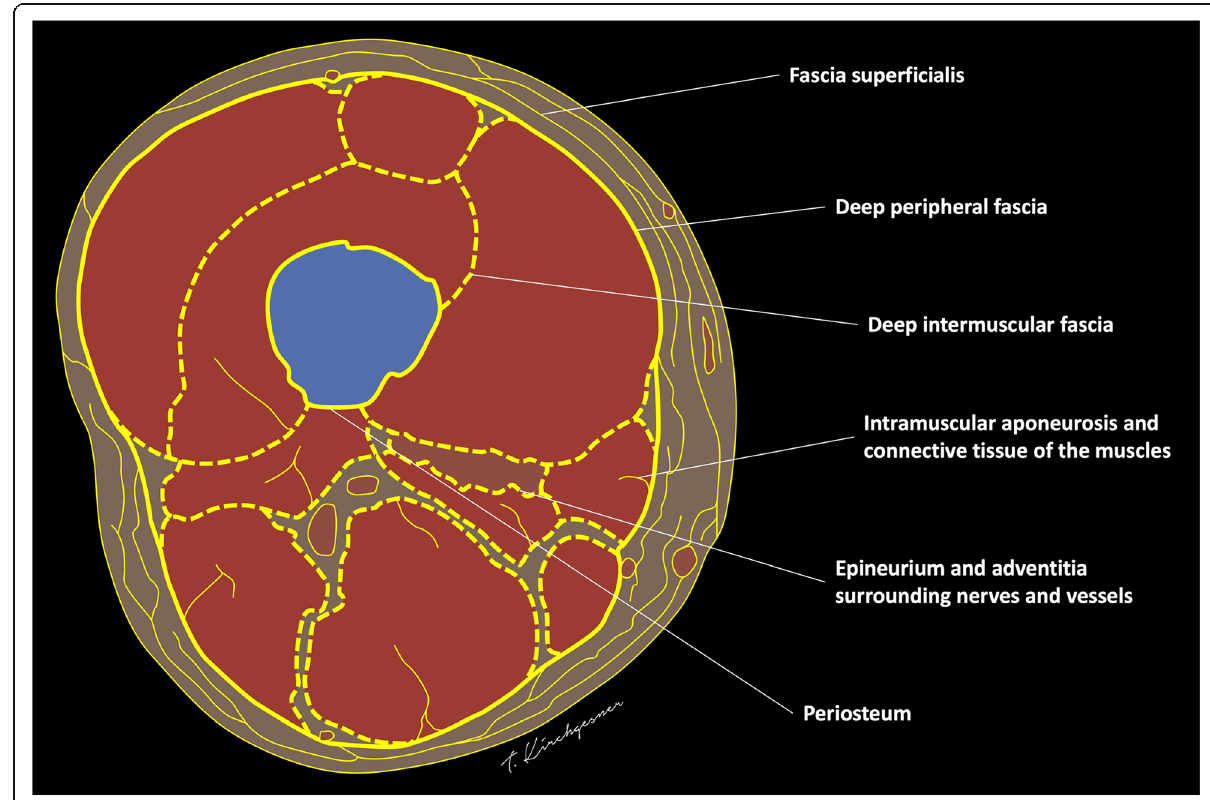
Fig. 1 Schematic drawing of a transverse section of the thigh illustrating its fascial